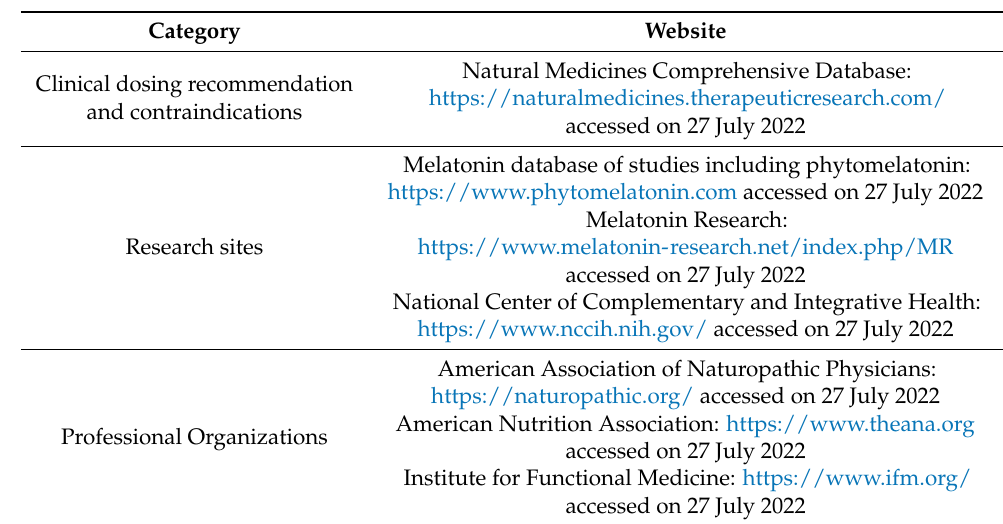
Table 6. Select Clinical Resources and Reference Sites for Information on Melatonin (Accessed on 27 July